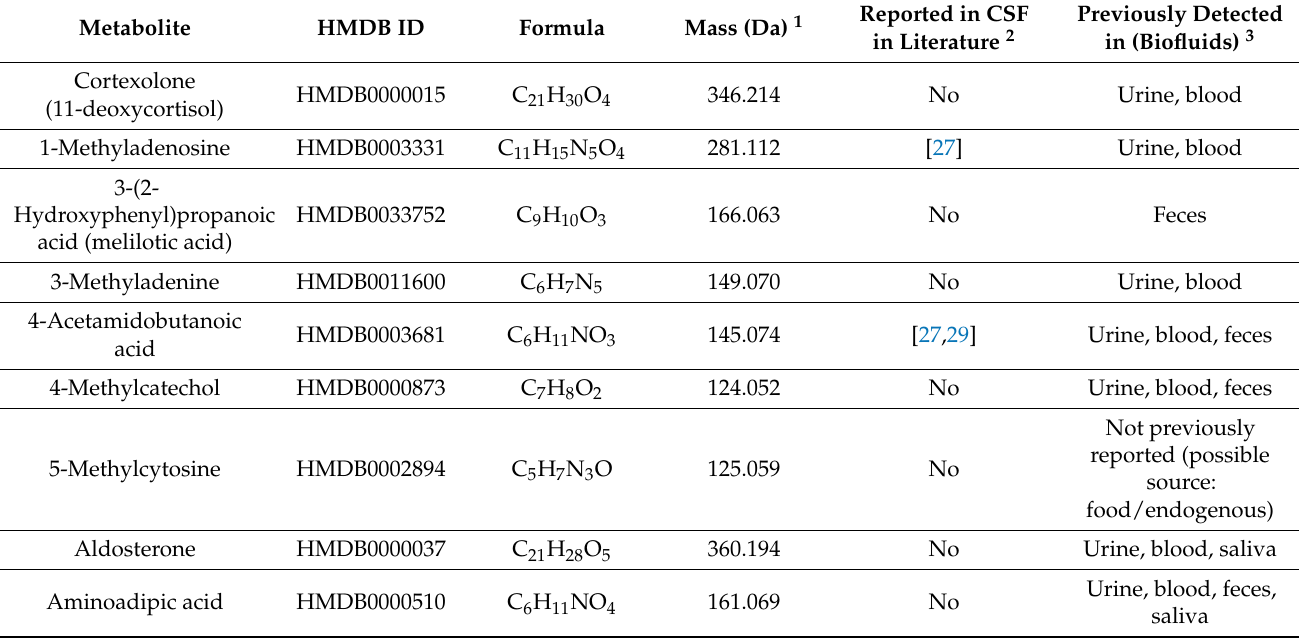
Table 1. CSF metabolites previously not reported in the Human Metabolome Database